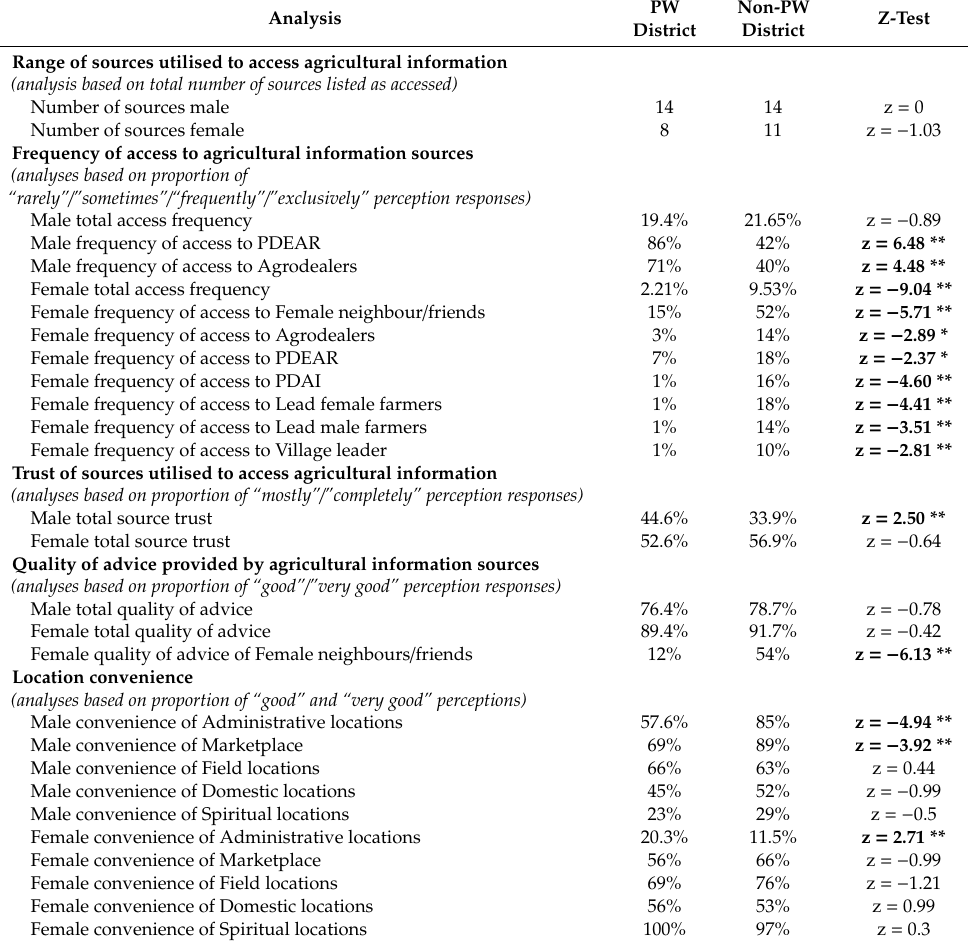
Table 1. Perception Di ff erences in Smallholder Agriculture Information Access. Descriptive and analytical statistics of proportion of male and female responses regarding information source range and convenience, frequency of access and source quality and trust. * Slightly significant result at p < 0.05; ** significant result at p << 0.05. Bold Z-test scores denotes significance. PW Non-PW Analysis Z-Test District District Range of sources utilised to access agricultural information (analysis based on total number of sources listed as